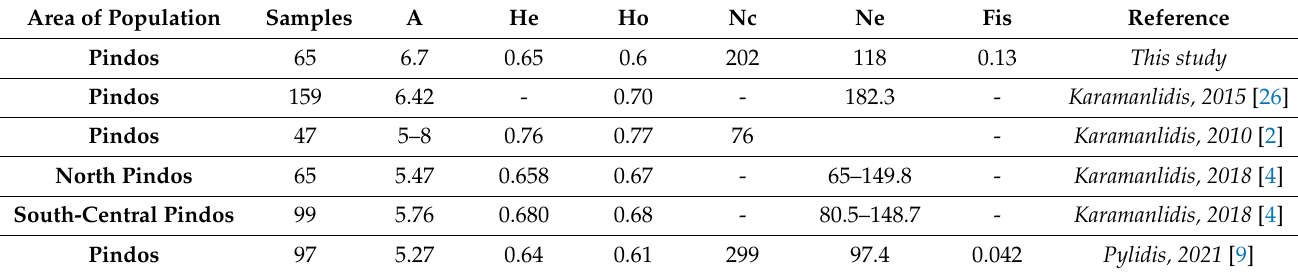
Table 10. Comparative table with studies carried out in Pindos (number of alleles (A); expected heterozygosity (He); observed heterozygosity (Ho); census population size (N C ); effective population size (Ne); inbreeding coefficient